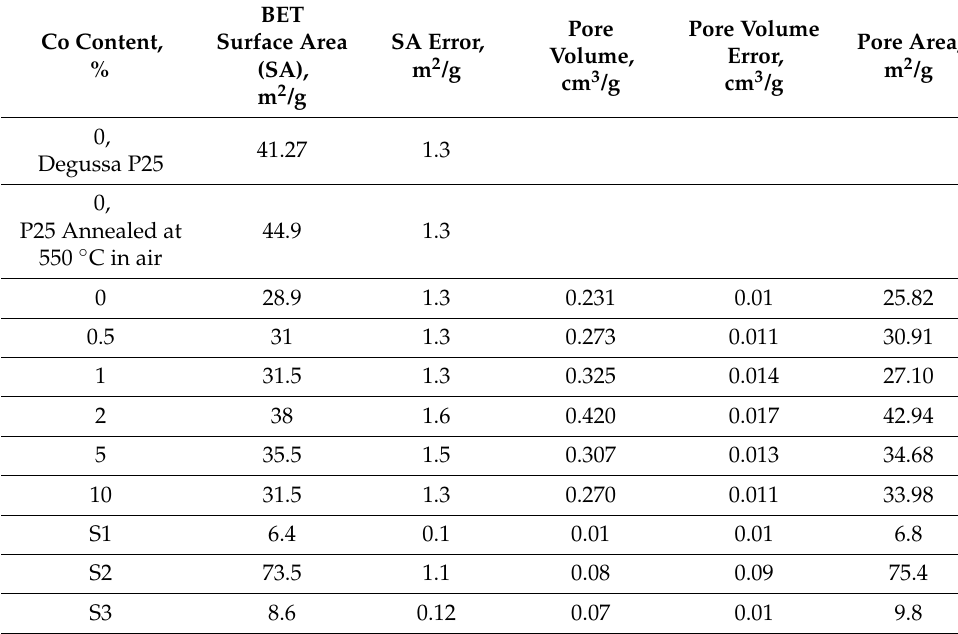
Table 3. BET specific surface areas and pore